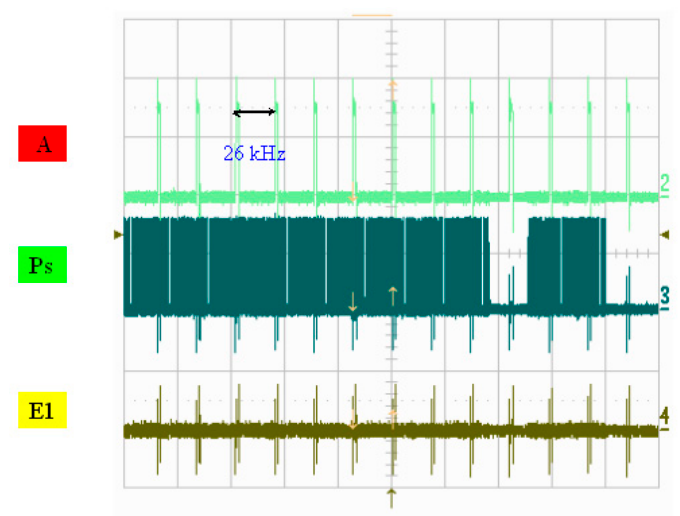
Figure 11. Frequency testing: draft Mode.